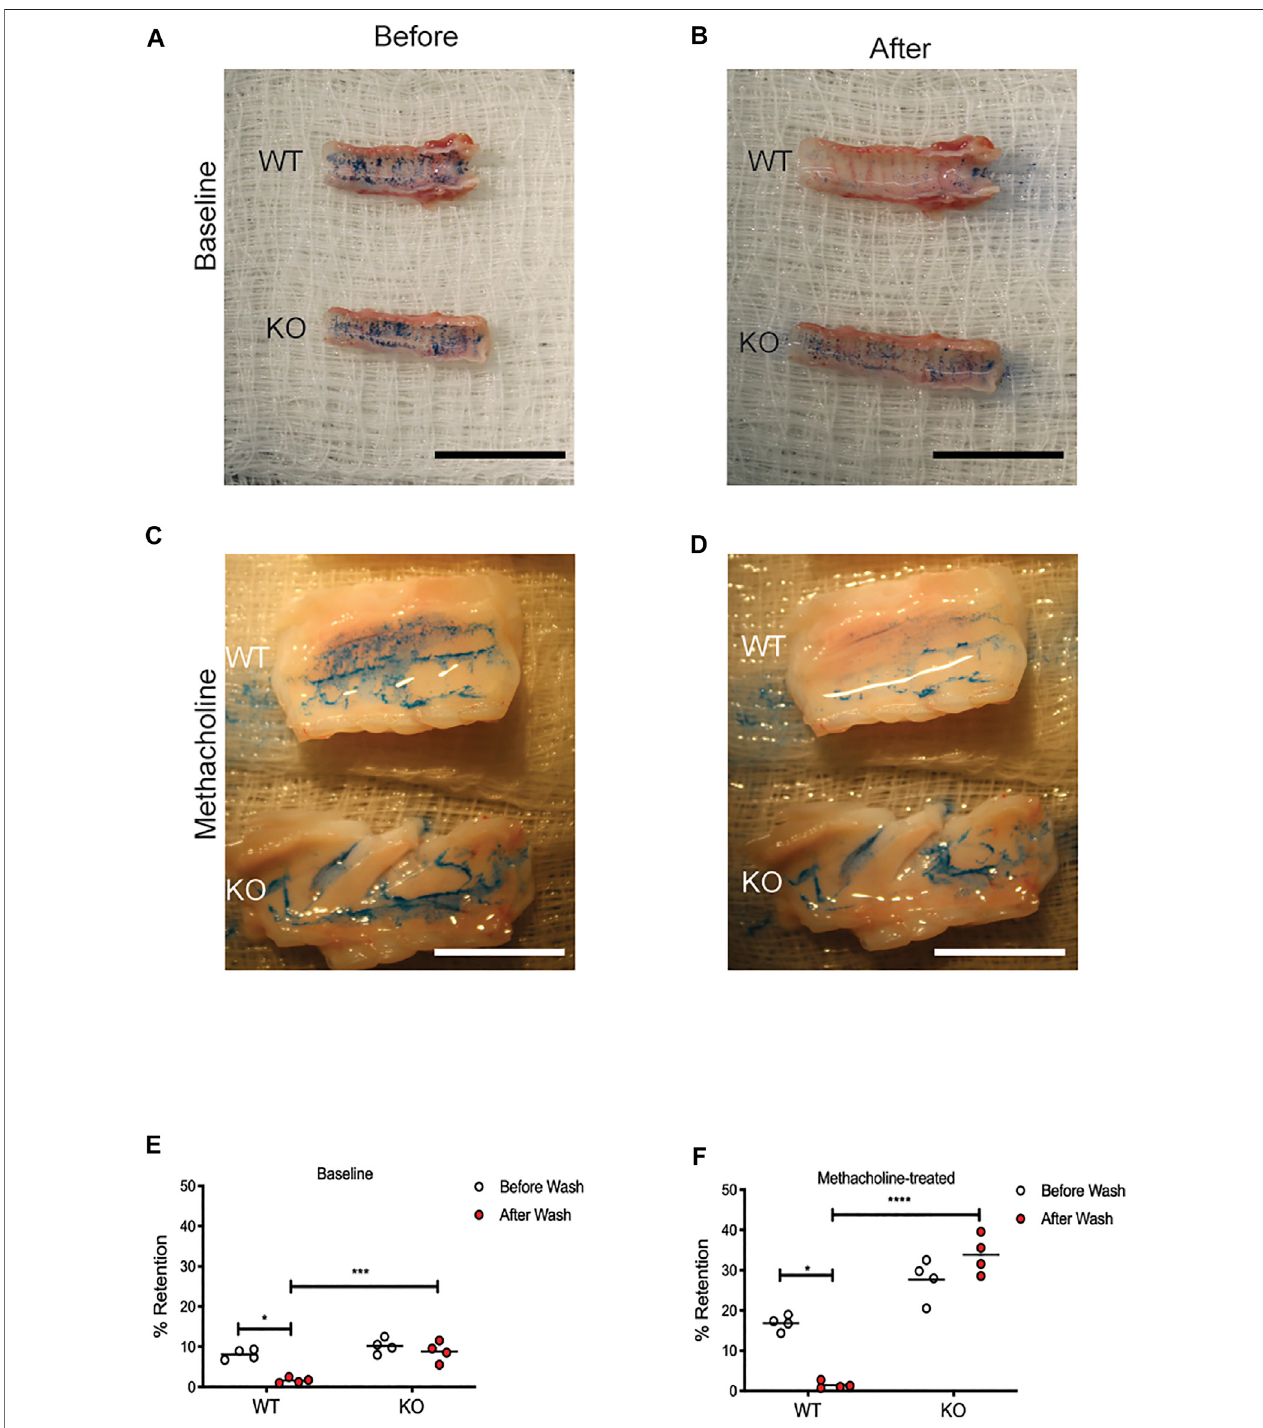
FIGURE 3 | Mucus is adherent to the CFTR-KO rat epithelium. Tracheae were excised from WT and KO rats at 6 months of age and incubated at physiologic temperatures. Adherence assays measured Alcian Blue on the surface of each trachea before and after rigorous washing. Representative images are shown from baseline (A) beforeand (B) afterwashingandinmethacholine-treatedrats (C) beforeand (D) aftermethacholineadministration.Blackscalebar=2 cm.%Retentionwas calculated using ImageJ from images collected at (E) baseline and (F) following methacholine stimulation. White scale bar = 1 cm. Lines represent mean. Mann- Whitney test was conducted to compare before and after from each condition. * p < 0.05, *** p < 0.001, **** p < 0.0001.